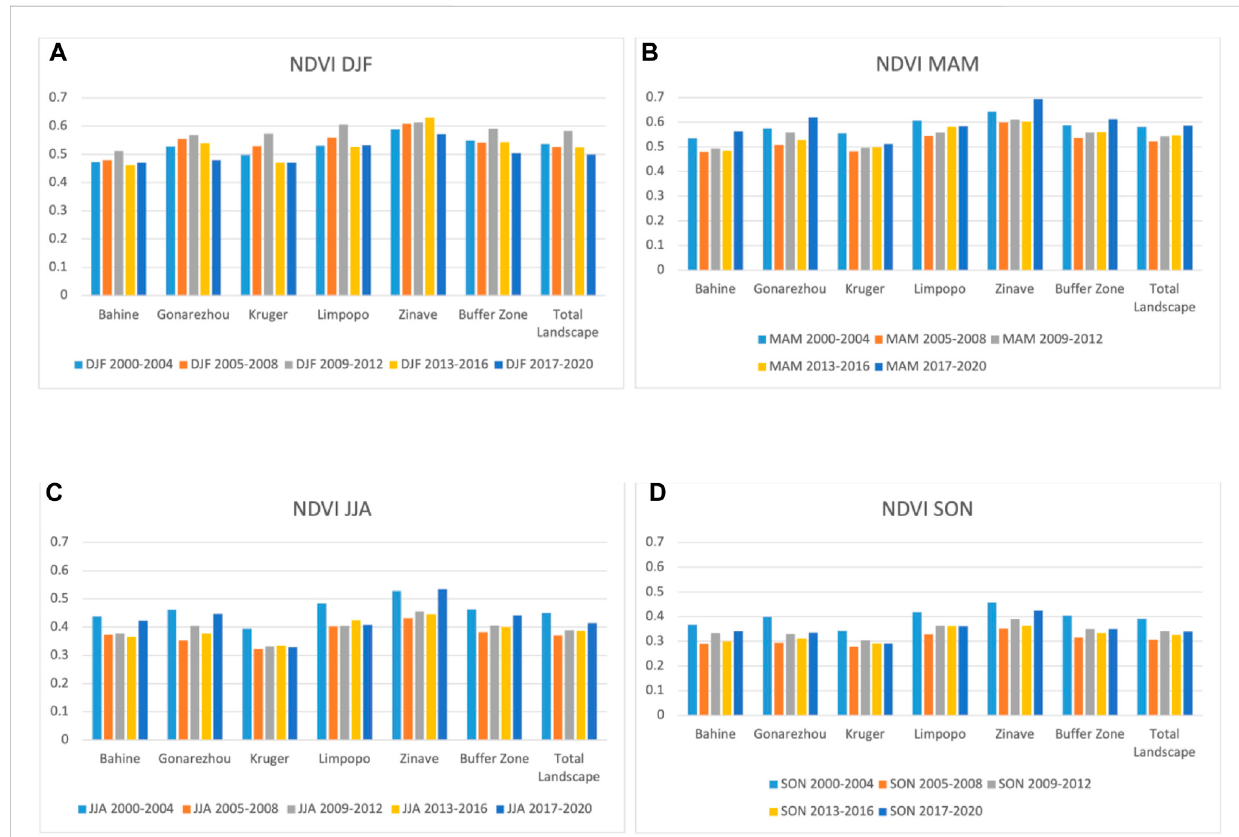
FIGURE 5 Mean Normalized Difference Vegetation Index (NDVI) by national park and season: (A) DJF, December, January, February; (B) MAM, March, April, May; (C) JJA, June, July, August; (D) SON, September, October,